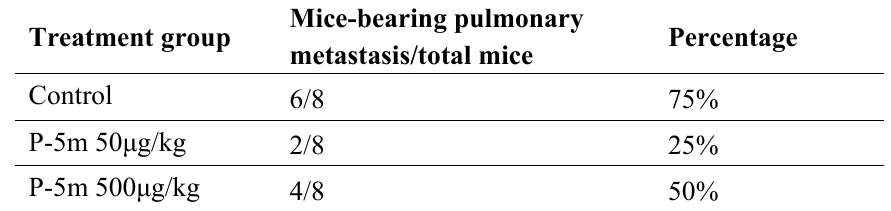
Table 1. Effect of P-5m peptide on lung metastasis in orthotopic model of HCC in nude